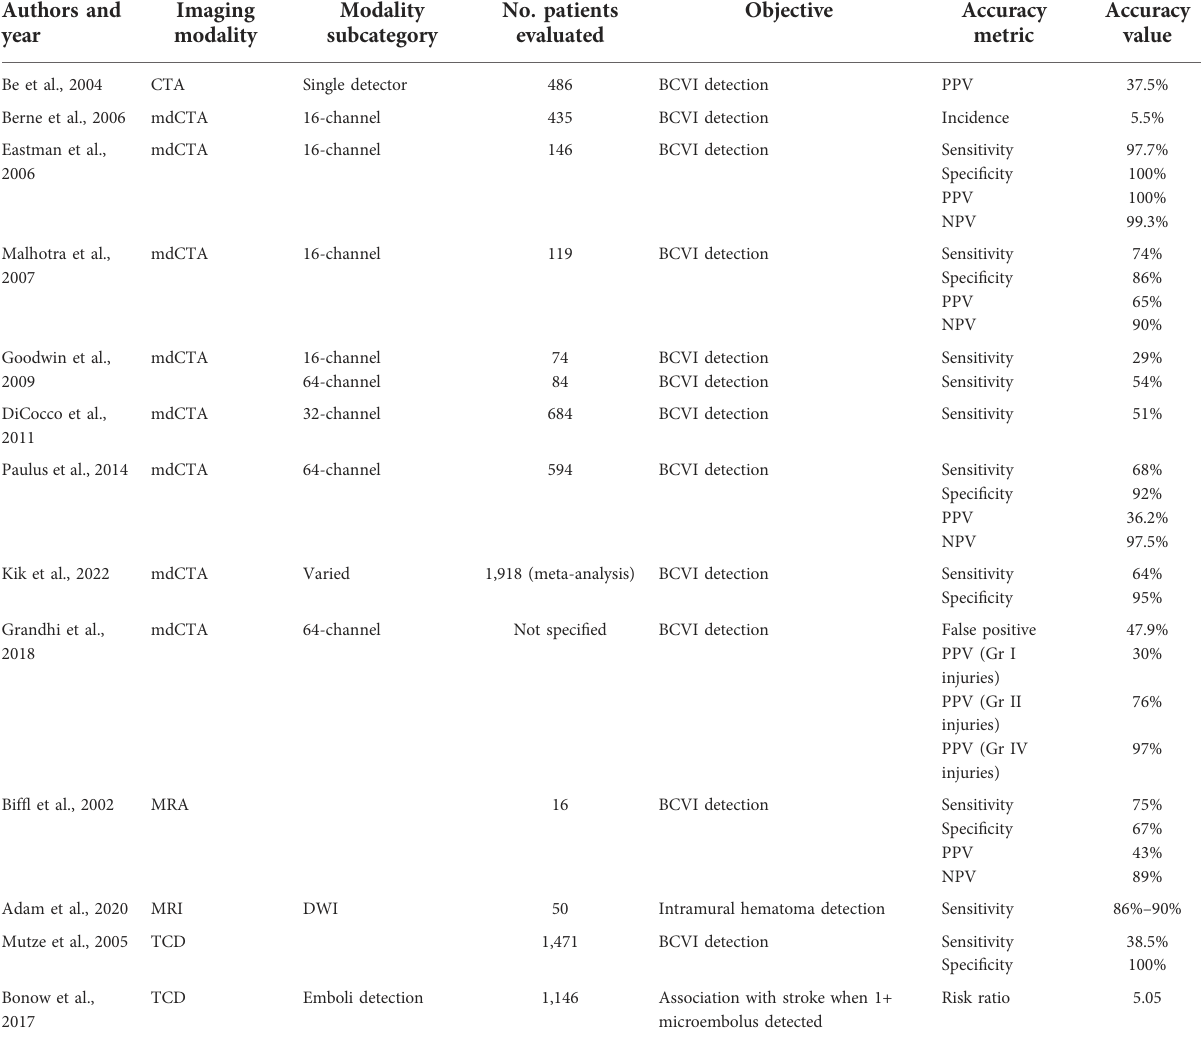
TABLE 1 Articles assessing accuracy of imaging modalities in detecting BCVIs and high-risk